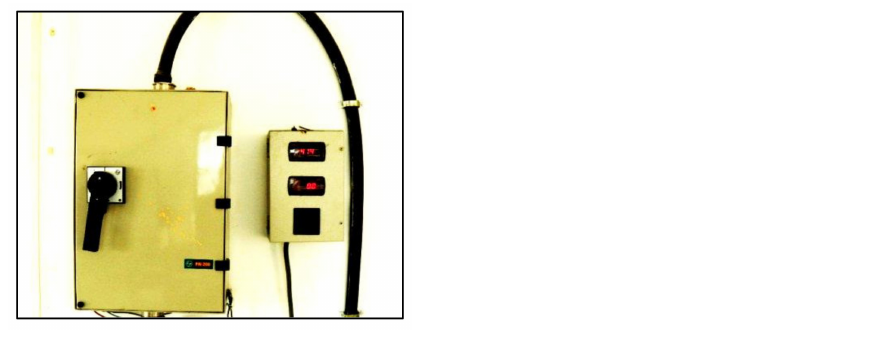
Figure 3. Power meter shows the reading of voltage and current during the mixing operation.